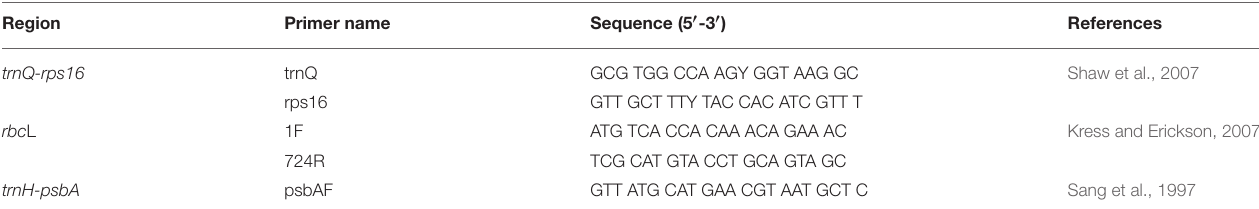
TABLE 2 | Details of primer pairs used to amplify the trnQ-rps16 , trnH-psbA, and rbc L gene. Region